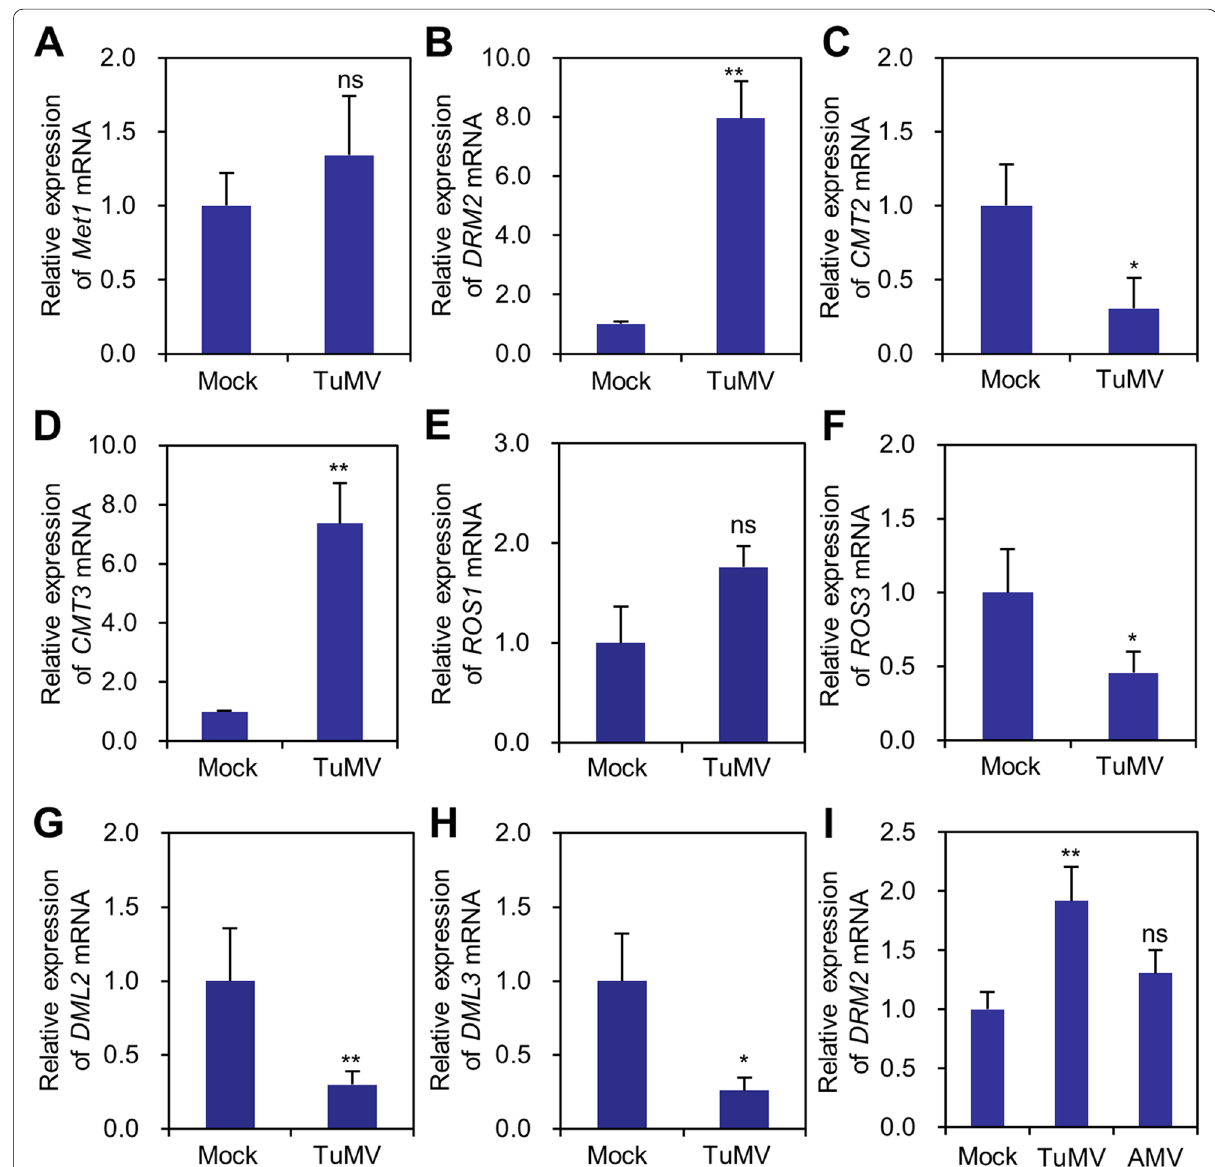
Fig. 2 RT-qPCR analysis the expression of DNA methylation-related genes in mock and TuMV-infected leaf tissues. A‑H The expression of MET1 ( A ), DRM2 ( B ), CMT2 ( C ), CMT3 ( D ), ROS1 ( E ), ROS3 ( F ), DML2 ( G ), DML3 ( H ) in mock and TuMV-infected leaf tissues, respectively. I RT-qPCR analysis the influence of TuMV and AMV infection to the expression of DRM2 . ACTIN II was used as the internal control. Transcript level in mock plants was normalized to 1. Data are mean s.d. ( n ± =